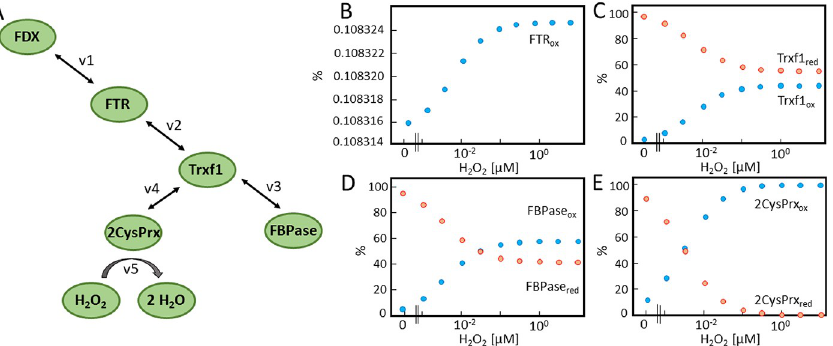
Fig 1. Simulated redox state of FTR-network components in dependence on H 2 O 2 concentration. (A) Schematic representation of the FTR-network. Electrons are drained from FD through FTR and TRX-f1 to either FBPase